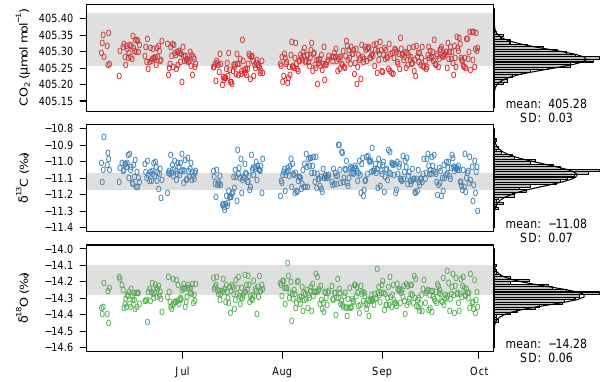
Fig. 4. Target gas measurements during four months (June to September 2012). The histograms show the distribution of the data with the respective mean and standard deviation. The shaded areas are the assigned values with the uncertainty (1 σ ) derived from the primary standard